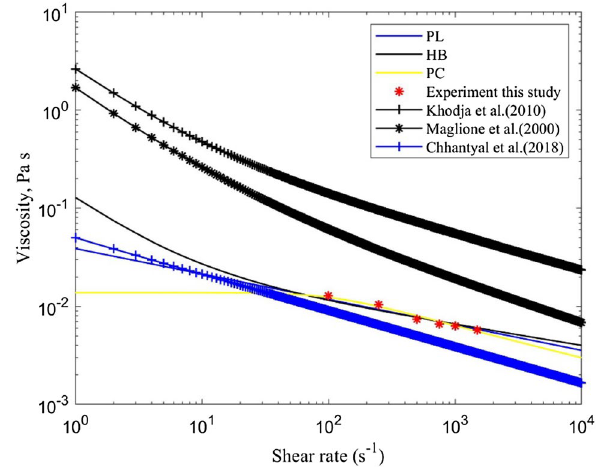
Fig. 4 Shear stress versus viscosity curves for the drilling mud used in this study. The model parameters are from Table 1. Experimental results are from the Anton Paar MCR 101 rheometer. PL, HB, and PC are model-fitted results from the experimental results. Khodja et al.’s (2010), Maglione et al.’s (2000), and Chhantyal’s (2018) drilling fluid data are also taken from the literature and used for the